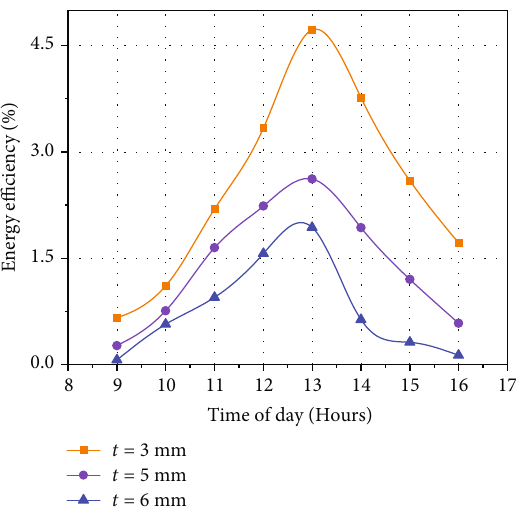
Figure 8: Time-wise fl uctuation of exergy e ffi